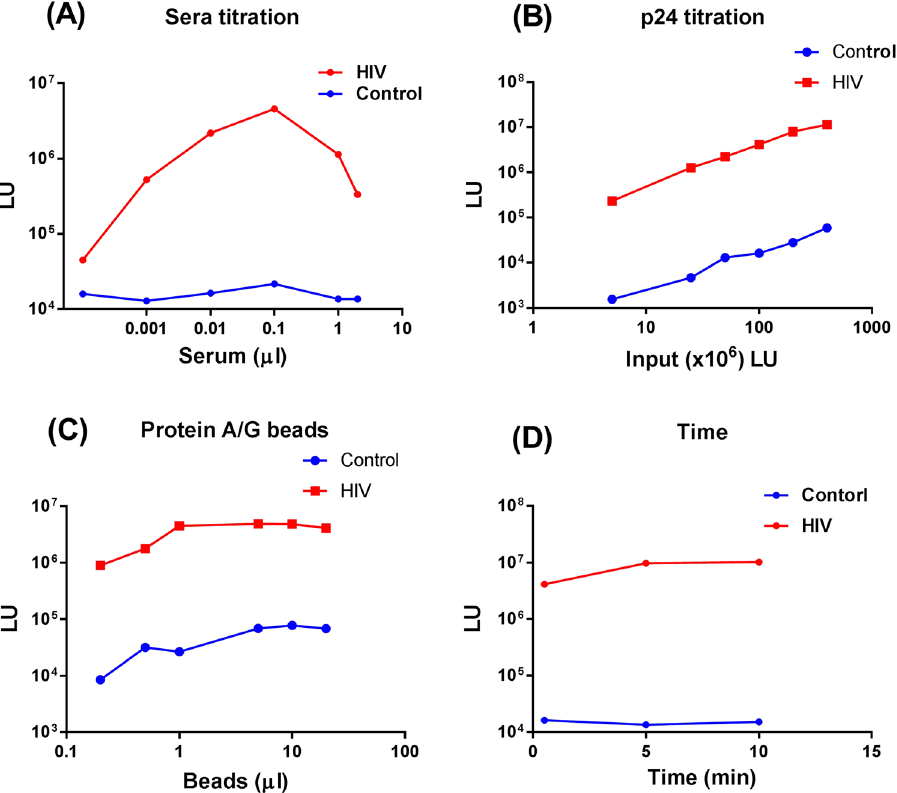
Figure 2. Parameters of the LIPSTICKS assay. The parameters of the LIPSTICKS assay were evaluated with one HIV negative and one HIV positive sera and is representative of multiple independent experiments. ( A ) Antibody detection by LIPSTICKS using extract containing HIV p24-luciferase fusion protein and dilutions of serum from the HIV negative (blue) and HIV positive individual (red). As shown, the highest signal to noise ratio for the HIV positive sera was obtained with 0.1 µ l of sera. ( B ) Increasing the amount of HIV p24 luciferase fusion protein produces a linear increase in LU for both the HIV negative and HIV positive samples. ( C ) Increasing the amount of paramagnetic protein A/G beads produced a saturated signal at approximately 1 µ l equivalent volume. ( D ) Increasing the incubation time of the sera with the HIV p24-luciferase fusion protein, from 30 seconds to 10 minutes, produced only a small increase in LU